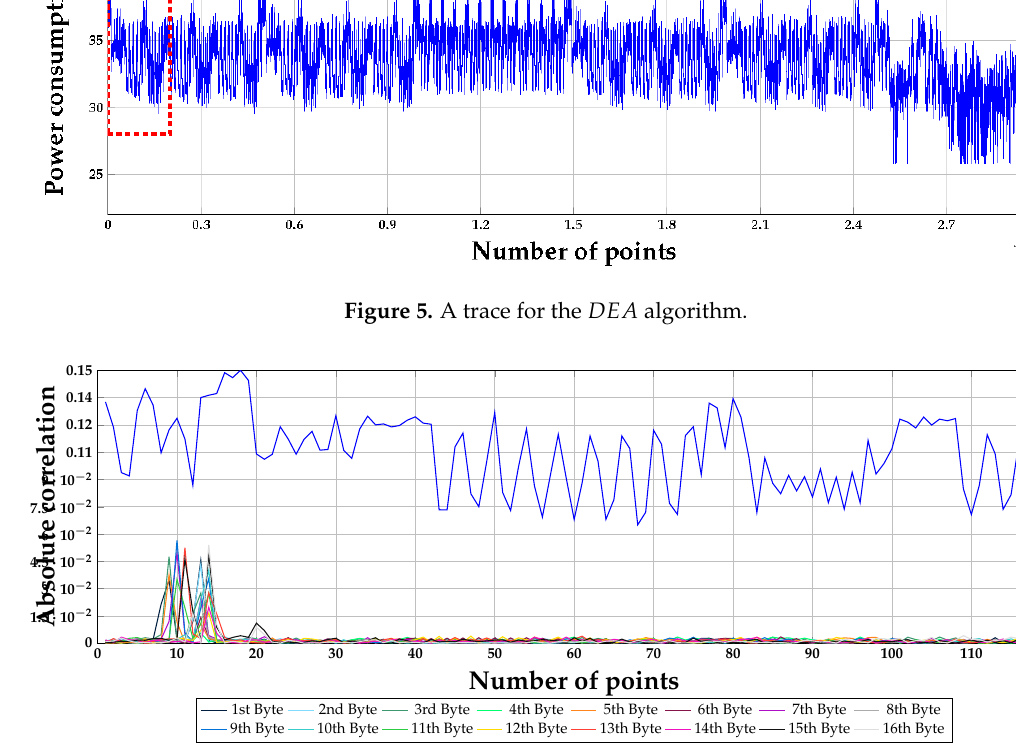
Figure 6. Result of correlation power analysis with plaintext